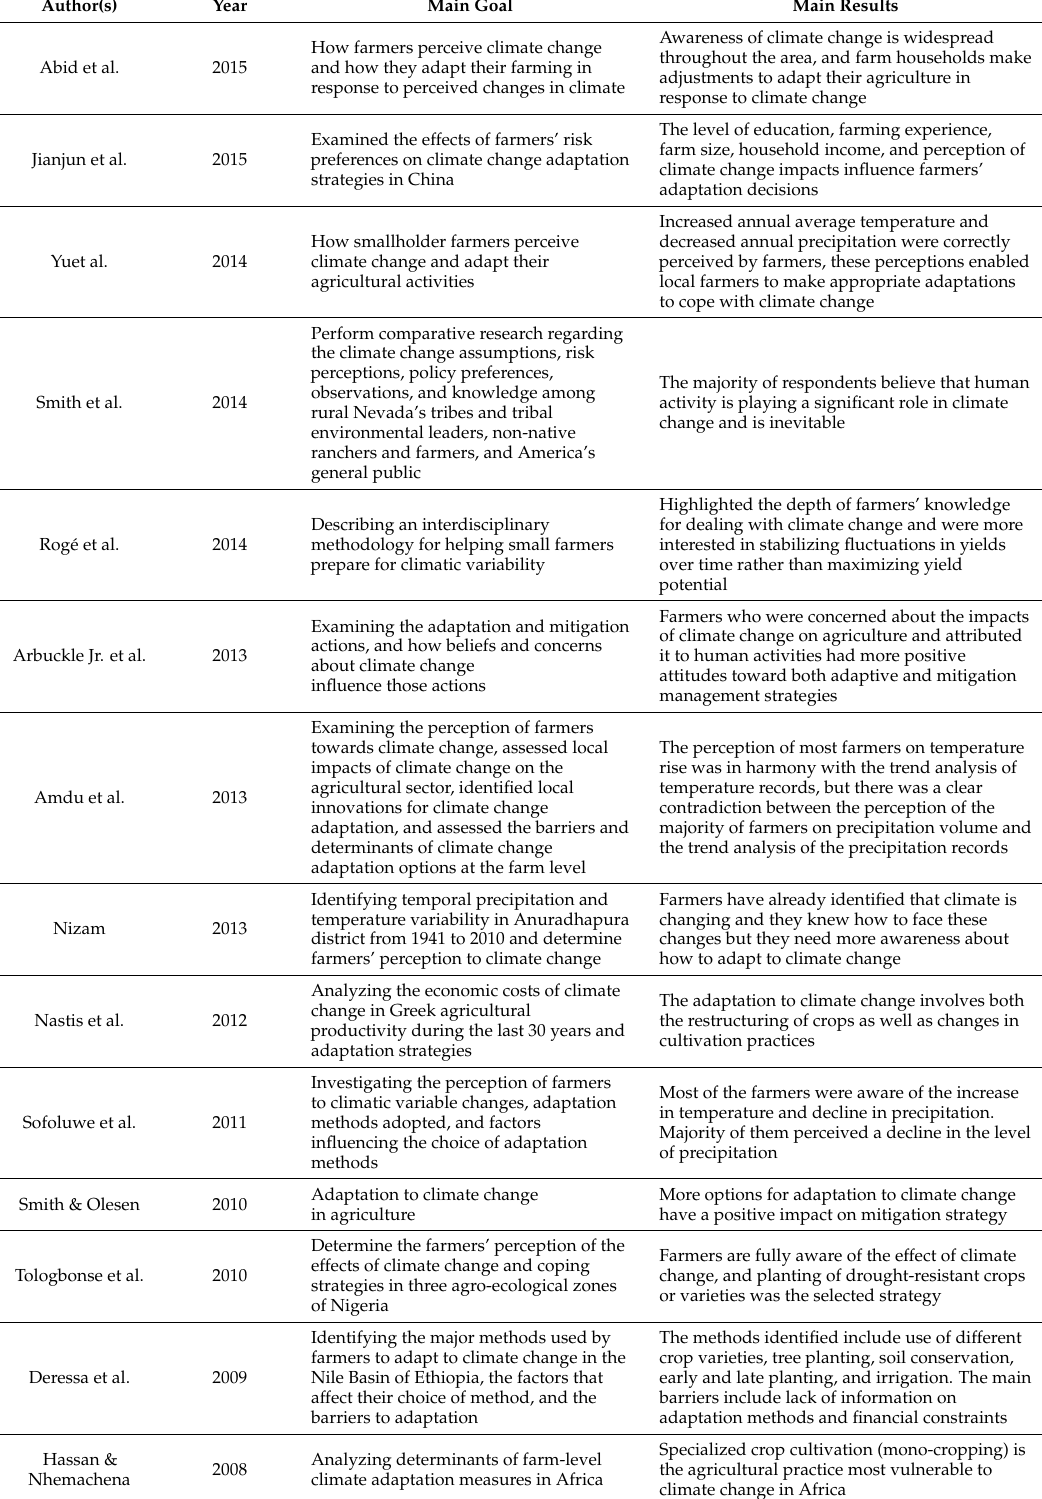
Table 1. Overview of integrated